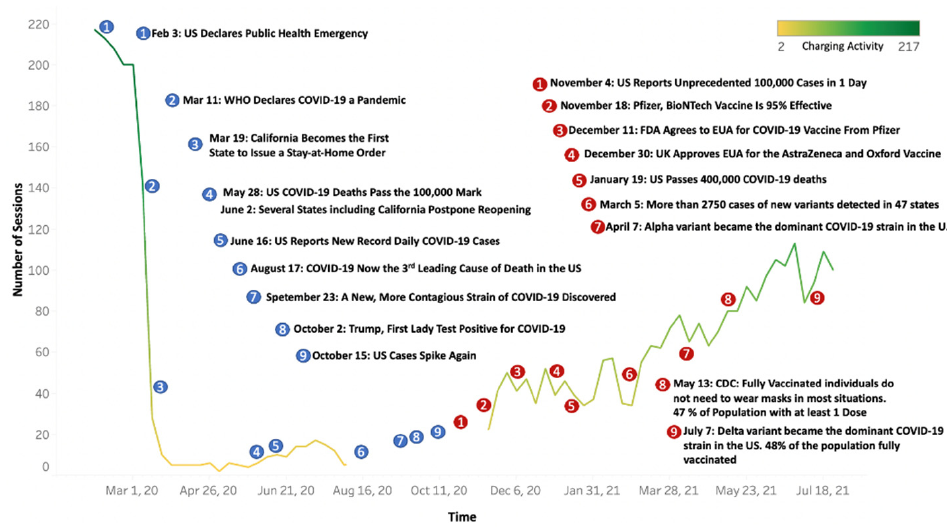
Figure 1. Charging activity by month during COVID-19.